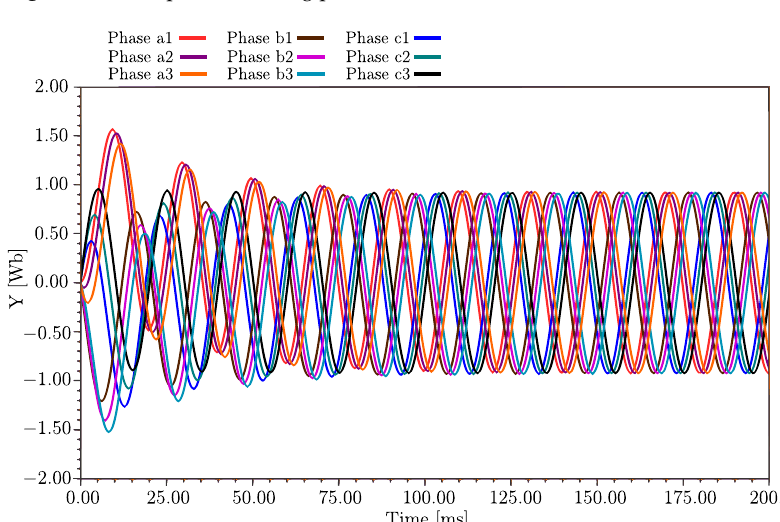
Figure 5. Three-phase winding plot fluxes.